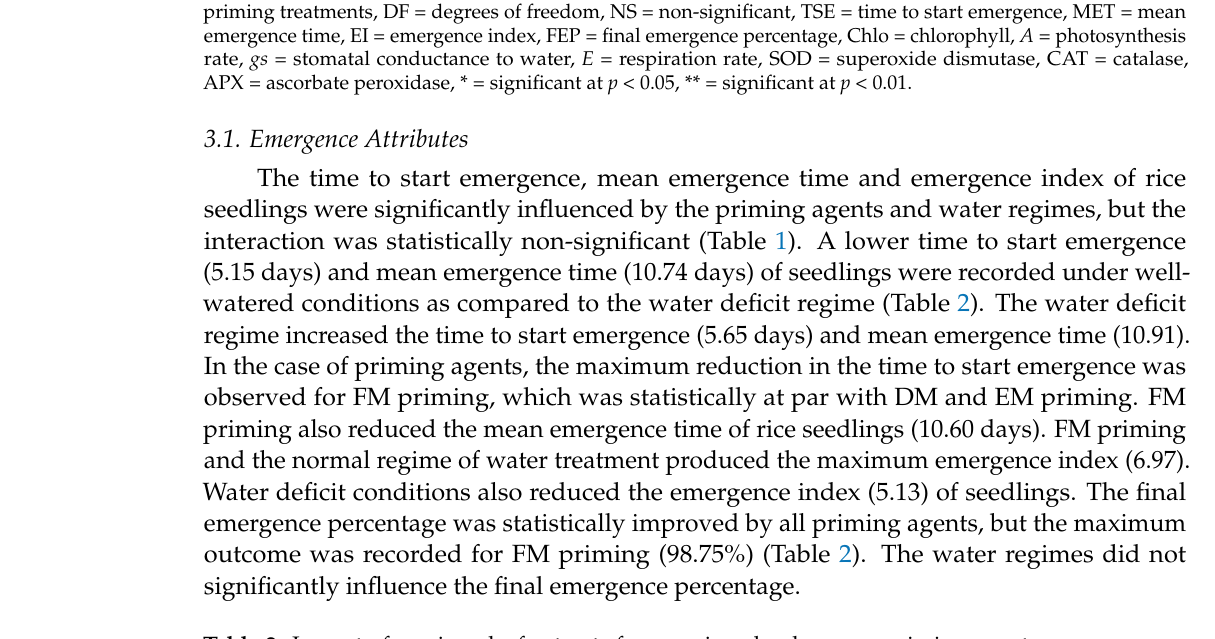
Table 2. Impact of moringa leaf extracts from various landraces as priming agents on emergence attributes of rice seedlings cultivated under control and water deficit